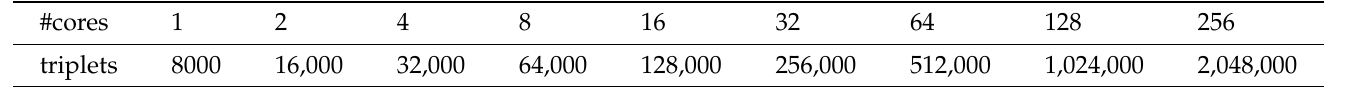
Table 2. Core/triplet assignment in the weak scaling experiment.